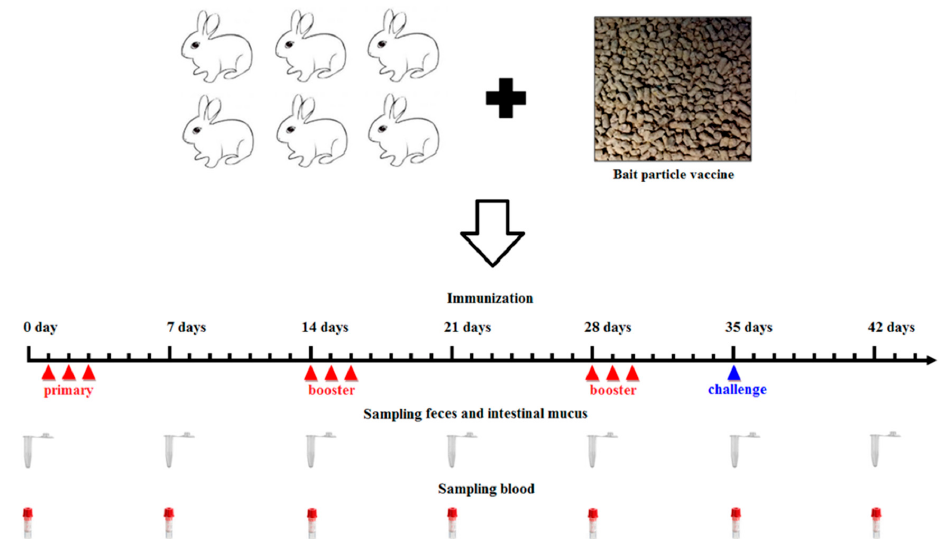
Figure 1. Diagrammatic representation of the oral immunization / challenge protocol and sampling time. Here, we used rabbits as an animal model to evaluate the immunogenicity of the bait particle vaccine. The immune protocol and sample collection times are shown in panel.